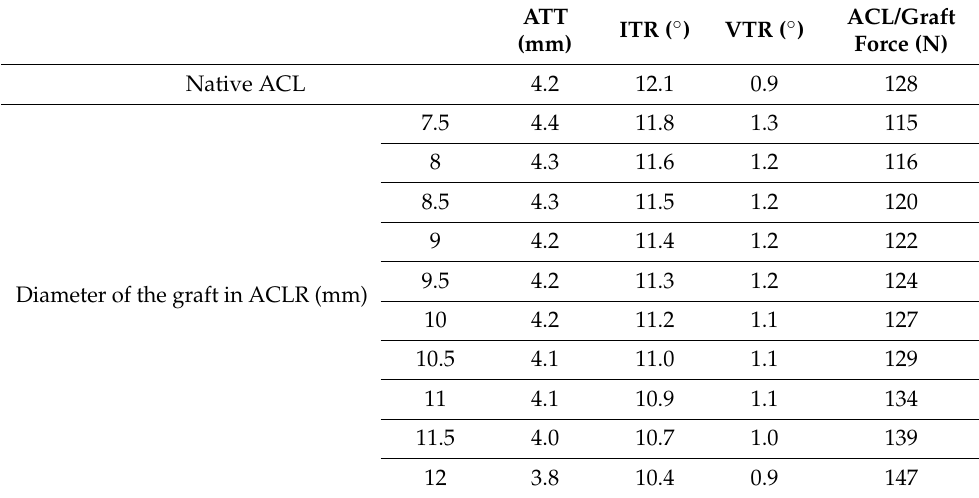
Table 2. Anterior tibial translation (ATT), internal tibial rotation (ITR), valgus tibial rotation (VTR) and ACL/graft force in the intact knee with a native-sized ACL and in the knee after anterior cruciate ligament reconstruction (ACLR) using different graft diameters.